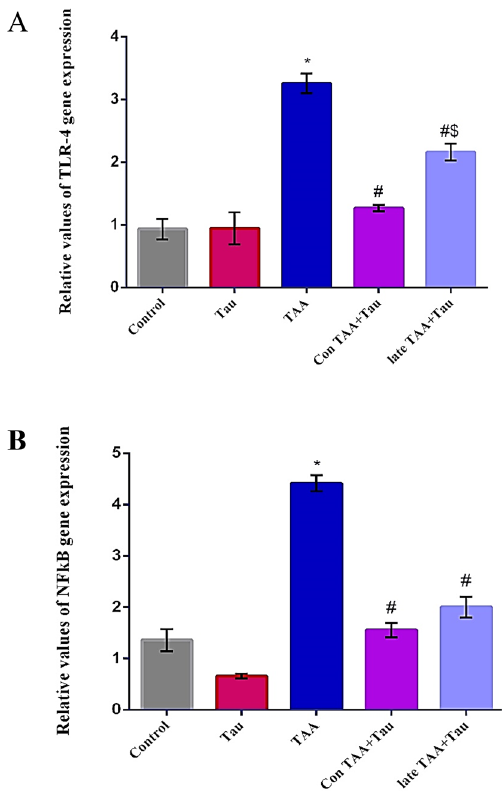
Figure 3. ( A ) Relative hepatic TLR-4 gene expression in control, Tau, TAA, Con TAA + Tau and late TAA + Tau groups. ( B ) Relative hepatic NFkB gene expression in control, Tau, TAA, Con TAA + Tau and late TAA + Tau groups. Values were expressed as mean ± SE. Number of rats in each group was 6. TLR-4: toll like receptor 4, NF-κB: nuclear factor-κB, Tau: taurine, TAA: thioacetamide. *: Significance against control group ( P < 0.05),